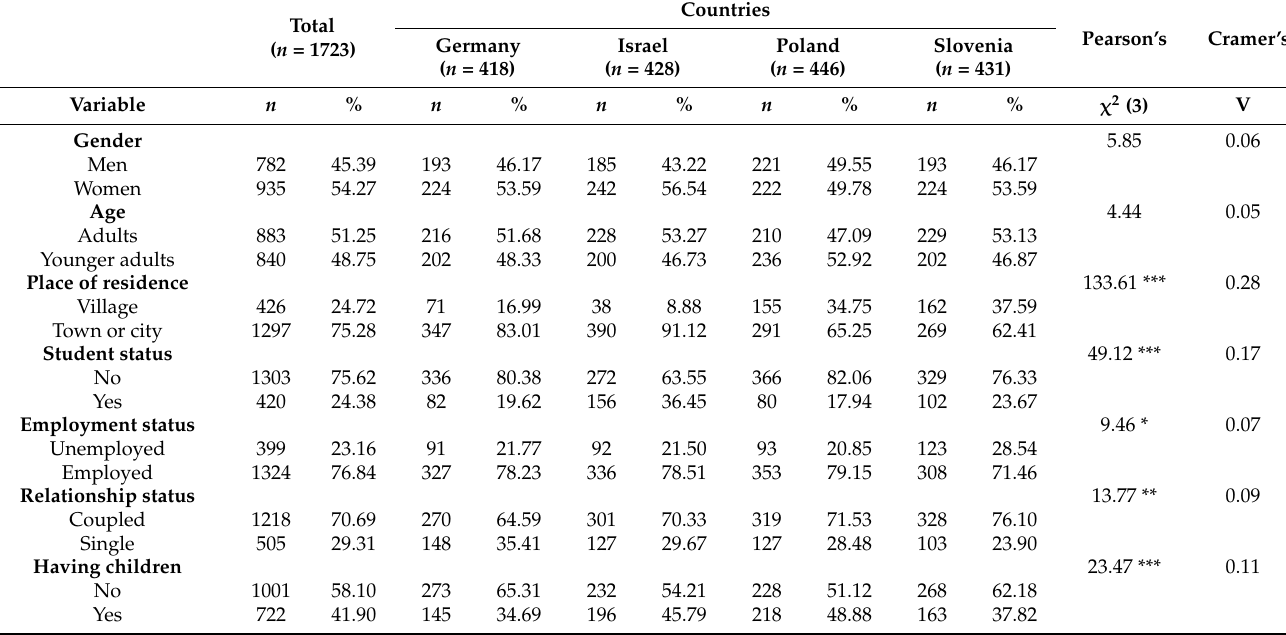
Table 1. Sociodemographic characteristics of the